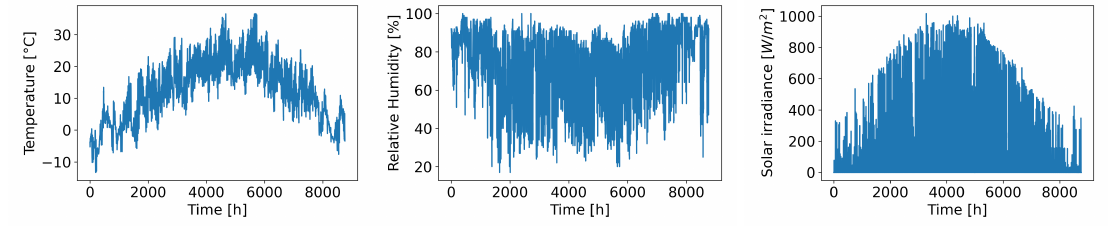
Figure 9. Ambient temperature, relative humidity and solar irradiance on a horizontal surface for standard Croatian continental climate (typical meteorological year).